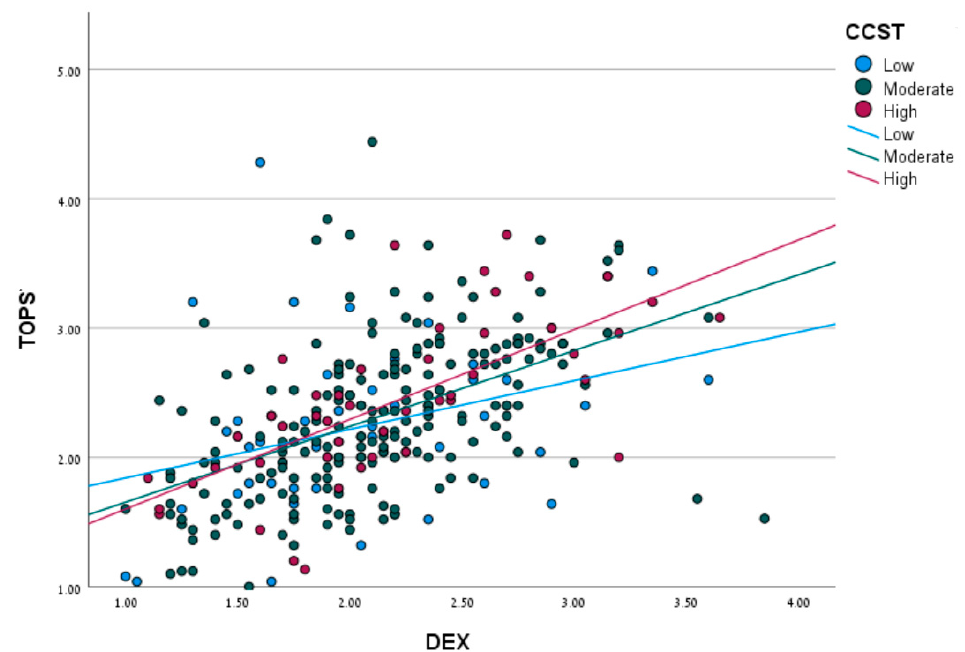
Figure 2. Moderation effect of cognitive strategy use on the relationships between executive functions and daily functioning.